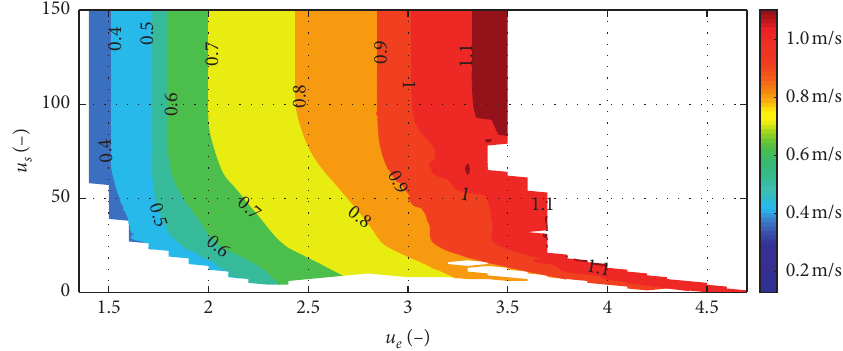
Figure 5: Walking velocities as a function of control parameters ( u